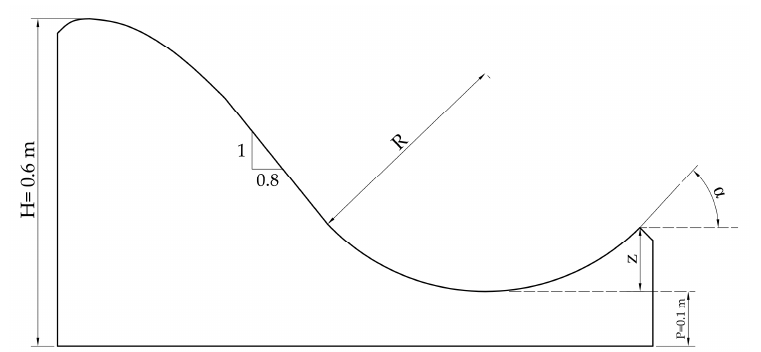
Figure 12. General geometry of the trampoline-type spillway. Table 7. Results of flow rate for the initiation of the jet flow Qi sim and flow depth y 0i sim at the lowest point, obtained with numerical simulation for each geometrical configuration.